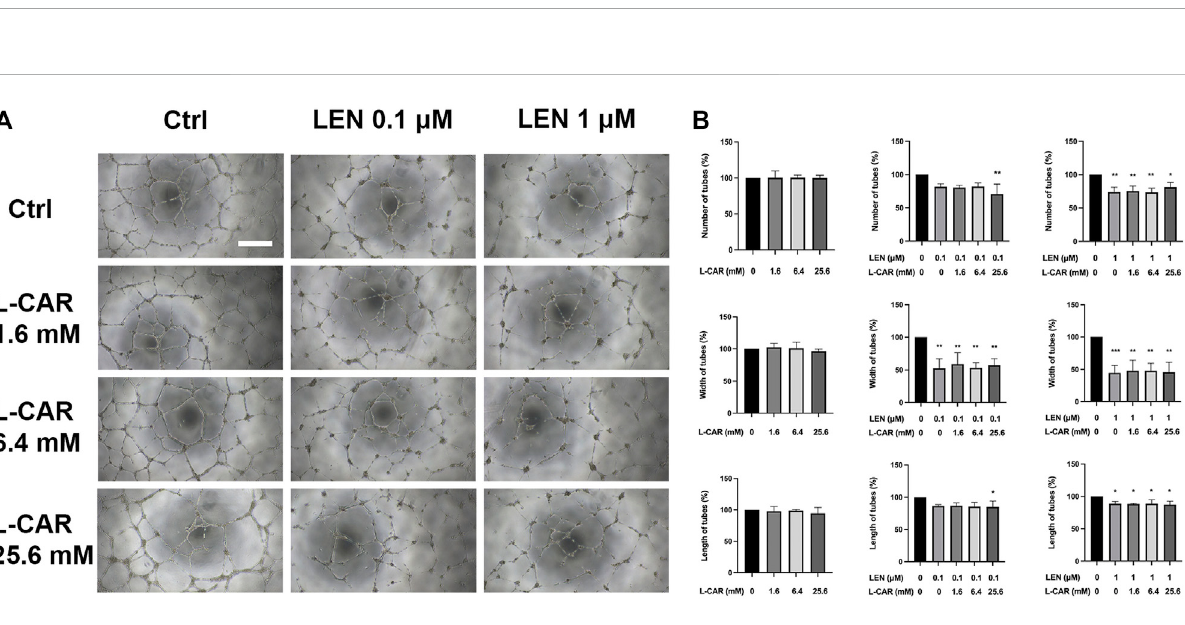
FIGURE 9 Effects of lenvatinib and/or L-carnitine on tube formation in HUVECs. The cells were treated with lenvatinib (0.1 or 1 µM), L-carnitine (1.6, 6.4, or 25.6 mM),and/orvehiclefor16 h.Thereafter,thenumber,width,andlengthoftubesineachwellweremeasuredusingtheImageJsoftware.Foranalyses of widthand length, the mean ofthe three maximum valuesfor each well was used. (A) Representative images of tube formation.The white barindicates 0.5 mm. (B) Data are presented as the mean +SD ( n = 3 from three independent experiments). * p < 0.05, ** p < 0.01 vs . Ctrl